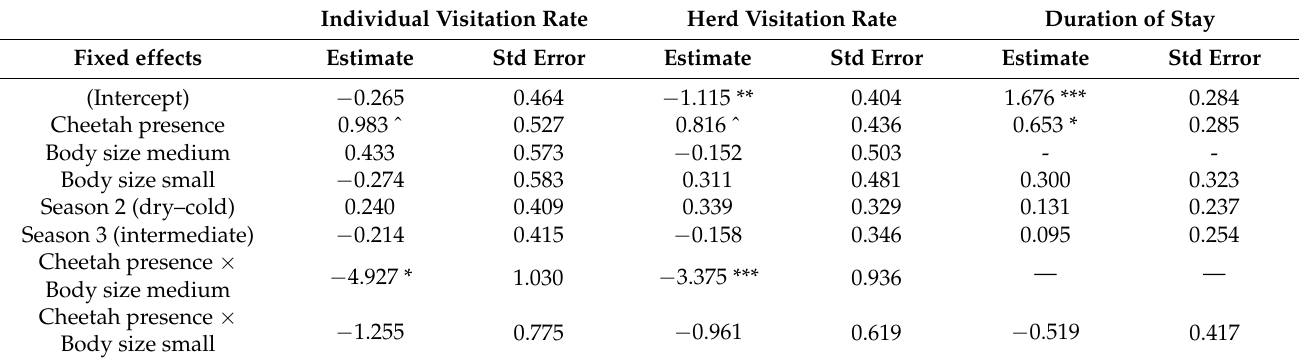
Table 2. Model estimates of individual visitation rate, herd visitation rate, and log-transformed dependent variable (duration of waterhole visit). Reference values are cheetah absence, large species, and season 1